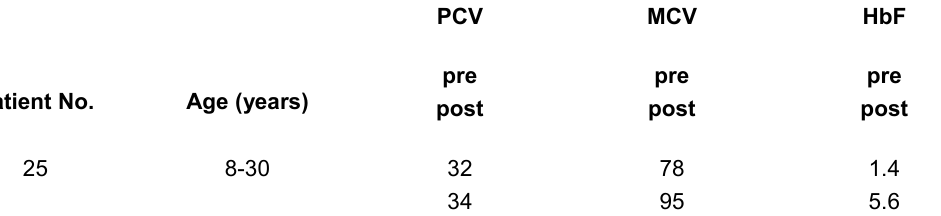
PCV MCV HbF pre pre post post